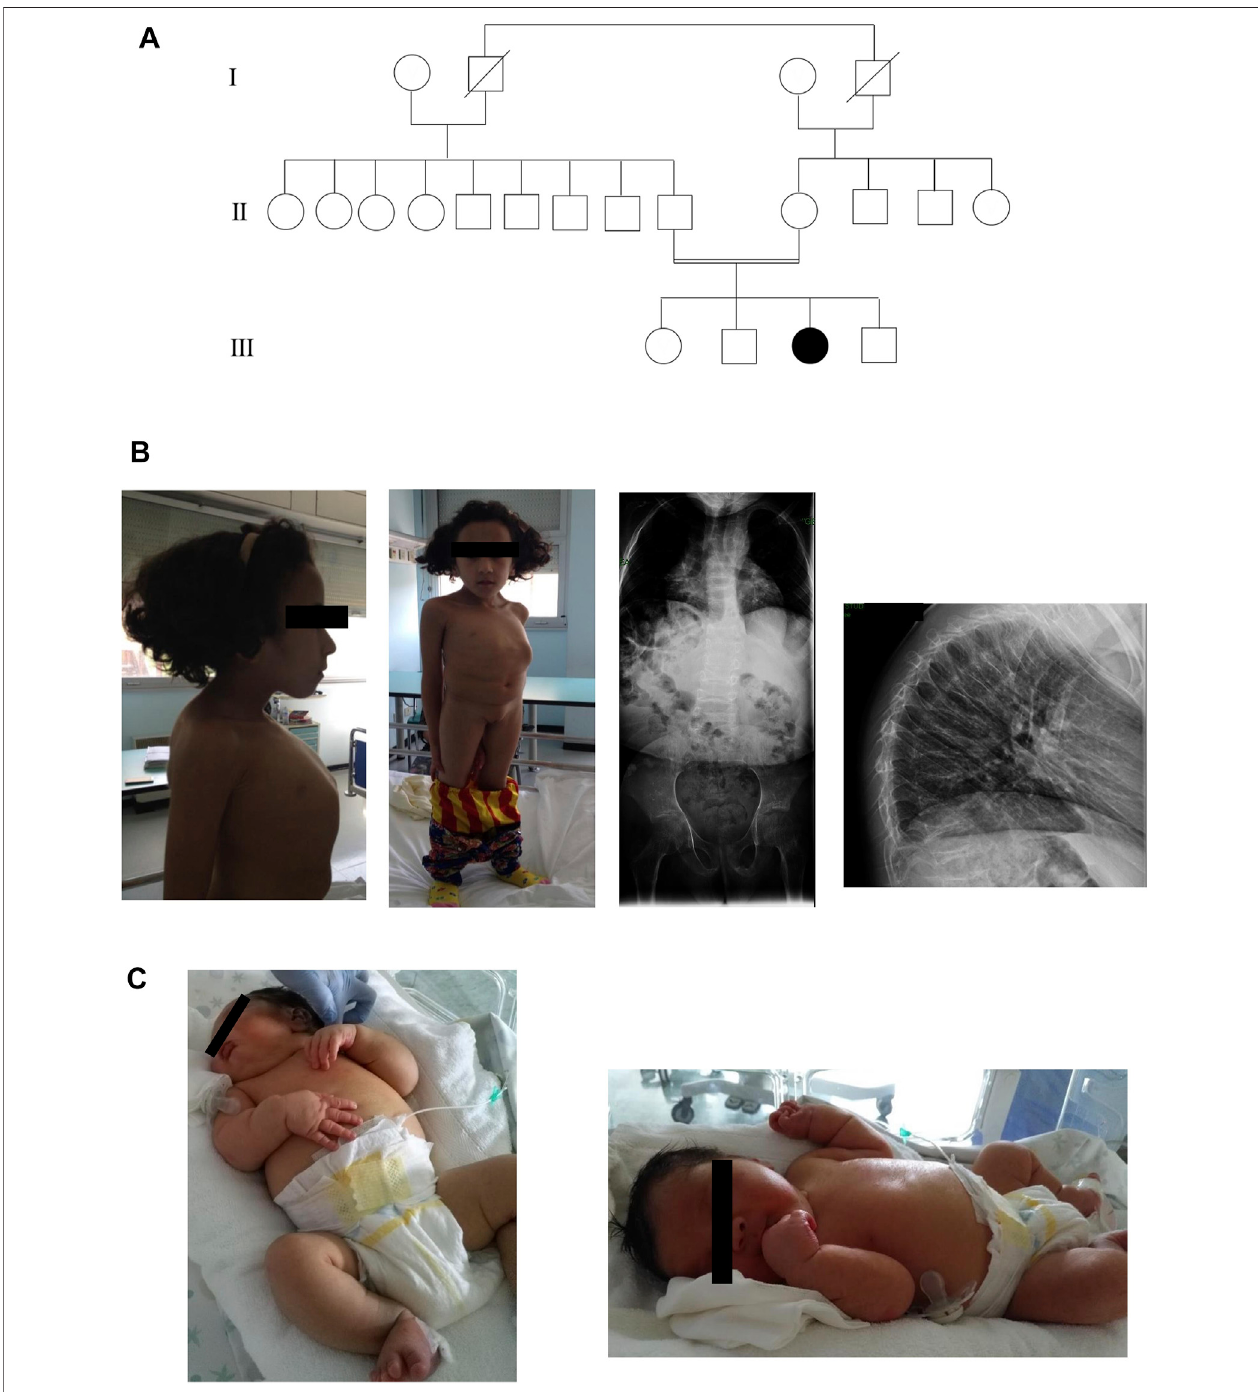
FIGURE 1 | (A) Three generations ofpedigree of family. (B) Anterior, lateral photographs and radiographs of sibling 1 that demonstrate platyspondyly with thinning of the vertebral bodies and secondary kyphosis. (C) Photographs of sibling 2 showing the main clinical